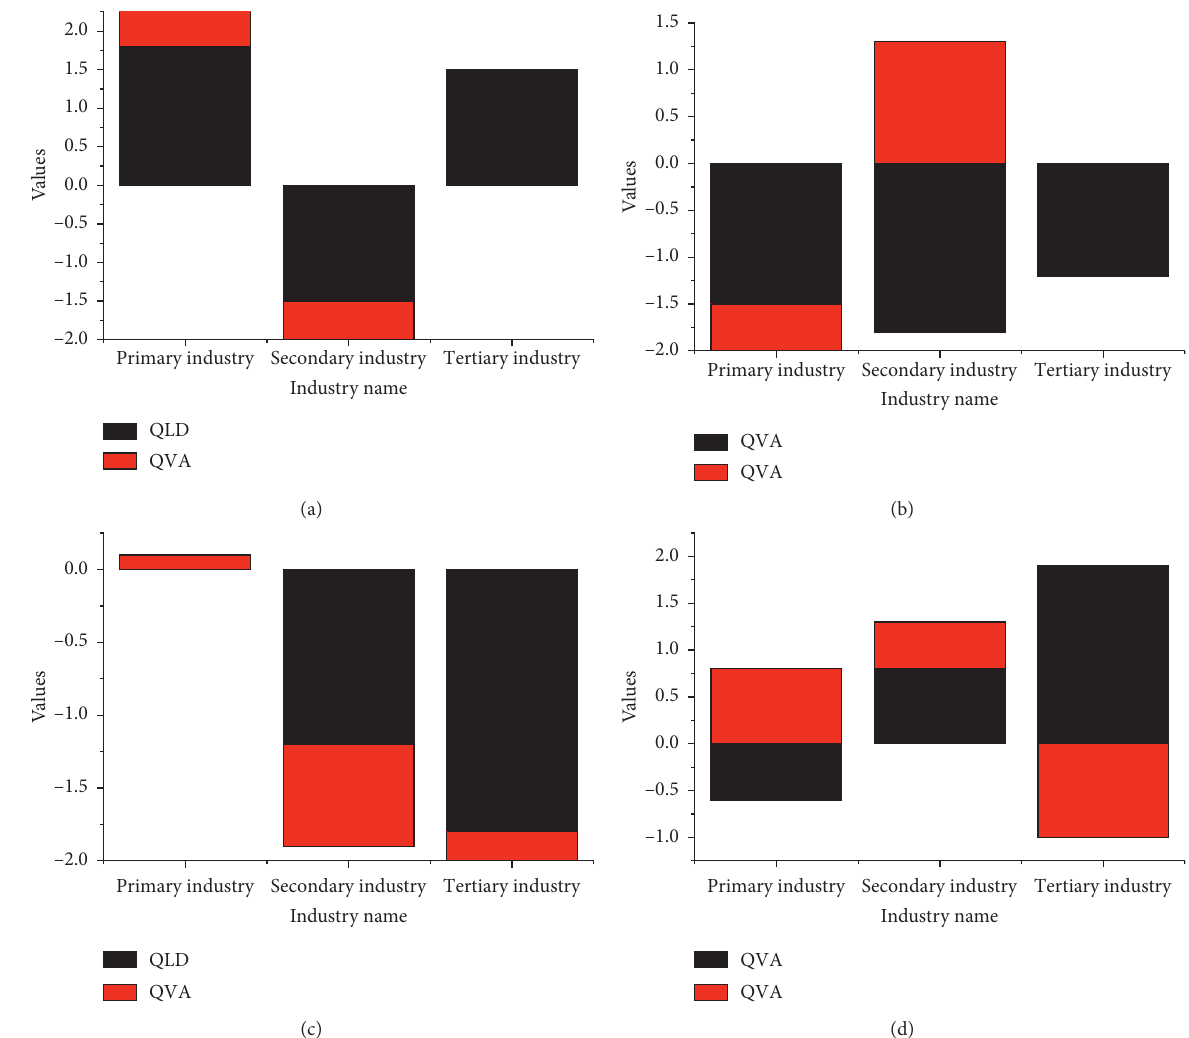
Figure 4: Structural impact of different simplification scenarios on three